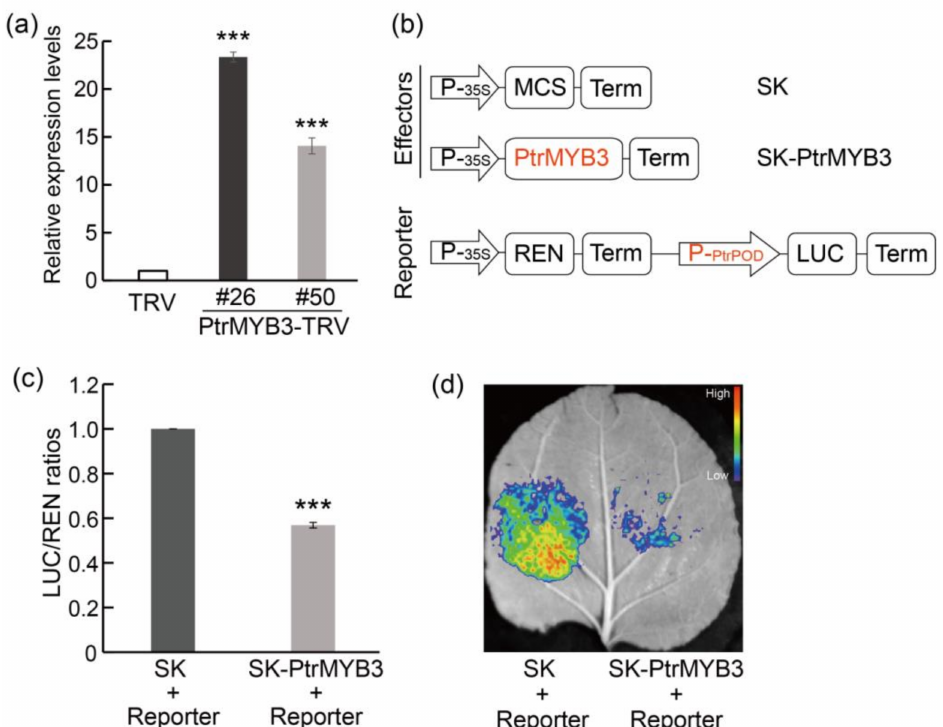
Figure 7. PtrMYB3 negatively regulates the expression of PtrPOD . ( a ) The relative expression levels of PtrPOD in WT and two PtrMYB3-silenced lines (#26 and #50). ( b ) Schematic diagrams of the reporter and the effectors used for dual-luciferase activity assay. P- 35S : CaMV35S promoter; Term: terminator; MCS: multiple cloning sites; REN: renilla luciferase; LUC: firefly luciferase; P- PtrPOD : the promoter of PtrPOD ; SK: pGreenII 62-SK vector. ( c ) The relative LUC/REN ratios in tobacco leaves transiently co-expressing the reporter and the effector. The LUC/REN ratio of empty vector (SK) without PtrMYB3 is set to 1. ( d ) The representative image of one tobacco leaf transiently co-expressing the reporter and the effector. The fluorescence intensity is indicated with different colors from low to high as shown in the color scale bar. Error bars indicate ± SE. Asterisks indicate significant differences: p < 0.001